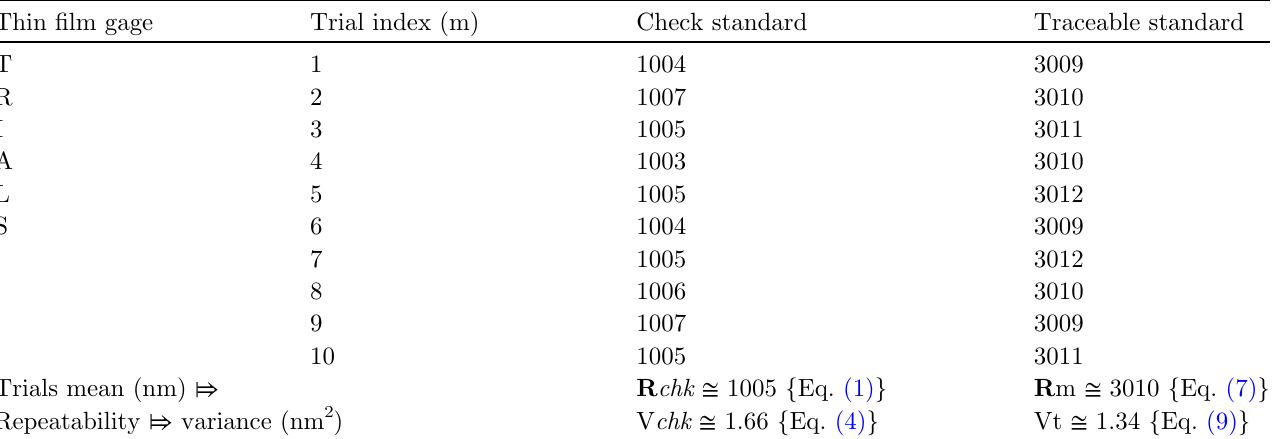
Table 1. Example 1. Check standard trials (measurement unit = nm.). Thin fi lm